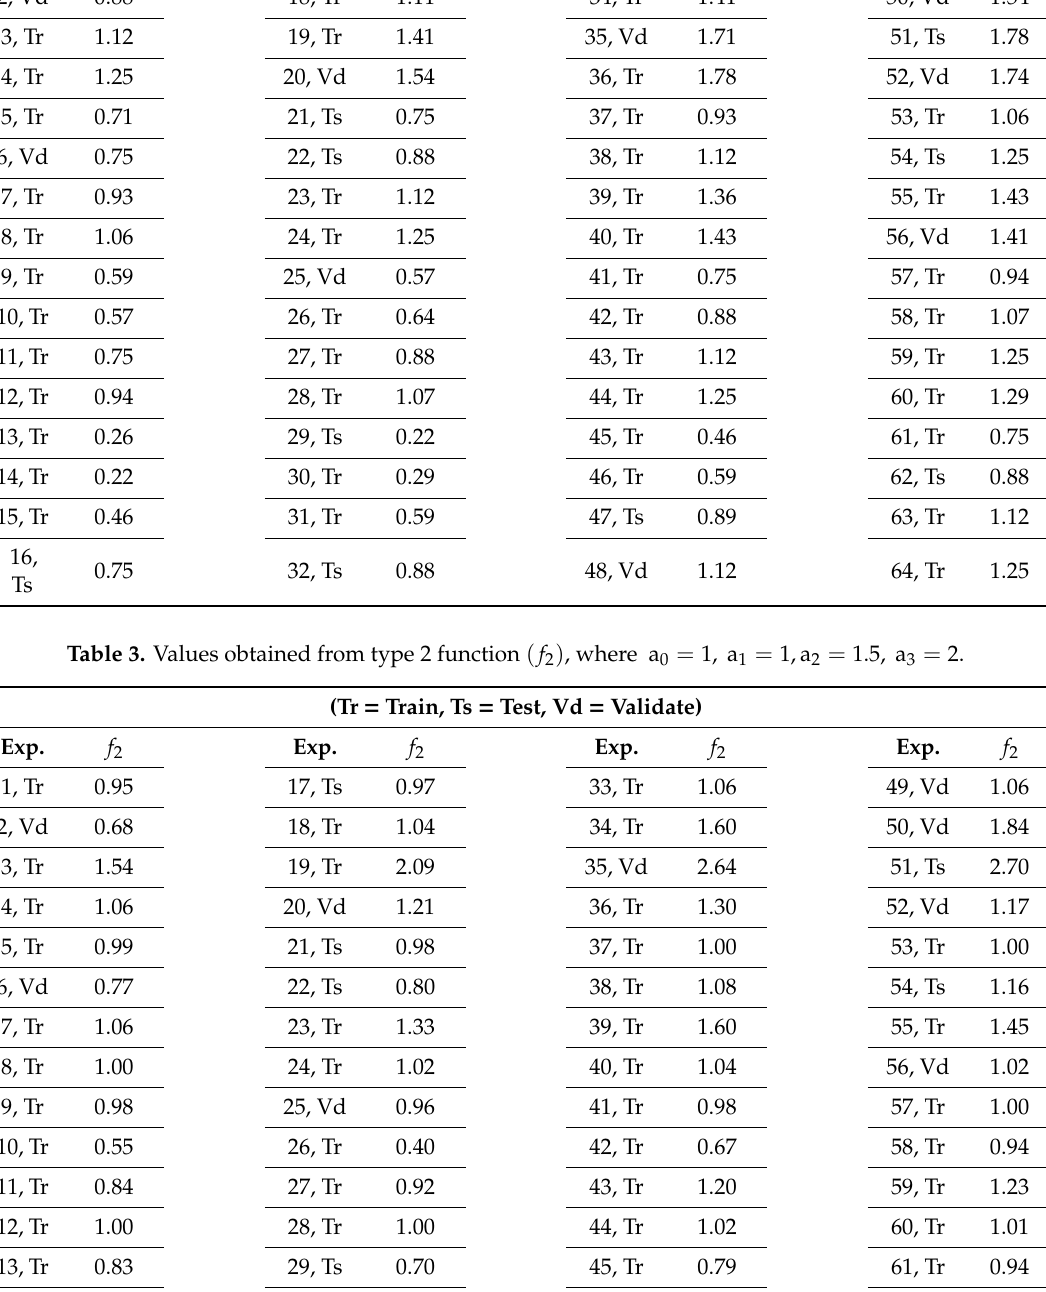
Table 2. Values obtained from type 1 function ( f 1 ) , where a 0 = 1, a 1 = a 2 = a 3 = 0.75. (Tr = Train, Ts = Test, Vd = Validate) Exp.